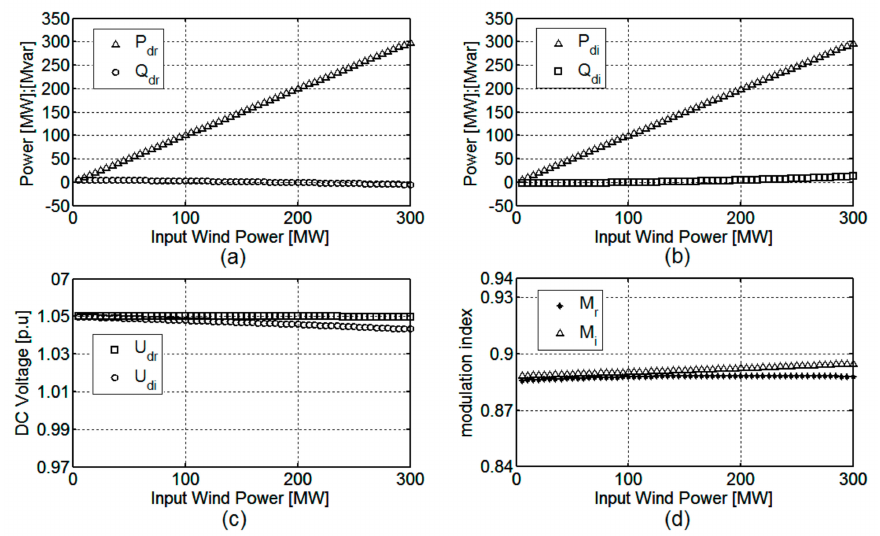
Figure 11. Steady-state curves with optimization: ( a ) Active and reactive power at the rectifier side of the VSC-HVdc model; ( b ) active and reactive power at the inverter side of the VSC-HVdc model;